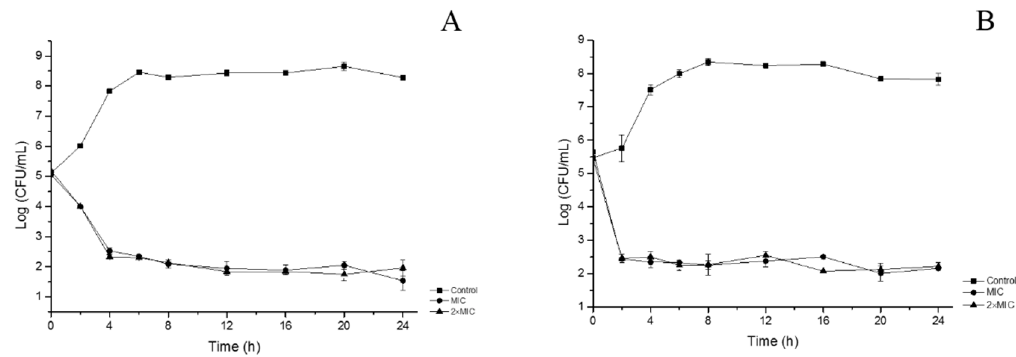
Figure 2. Time-kill analysis of E. coli and S. aureus . ( A ): E. coli ; ( B ): S. aureus .